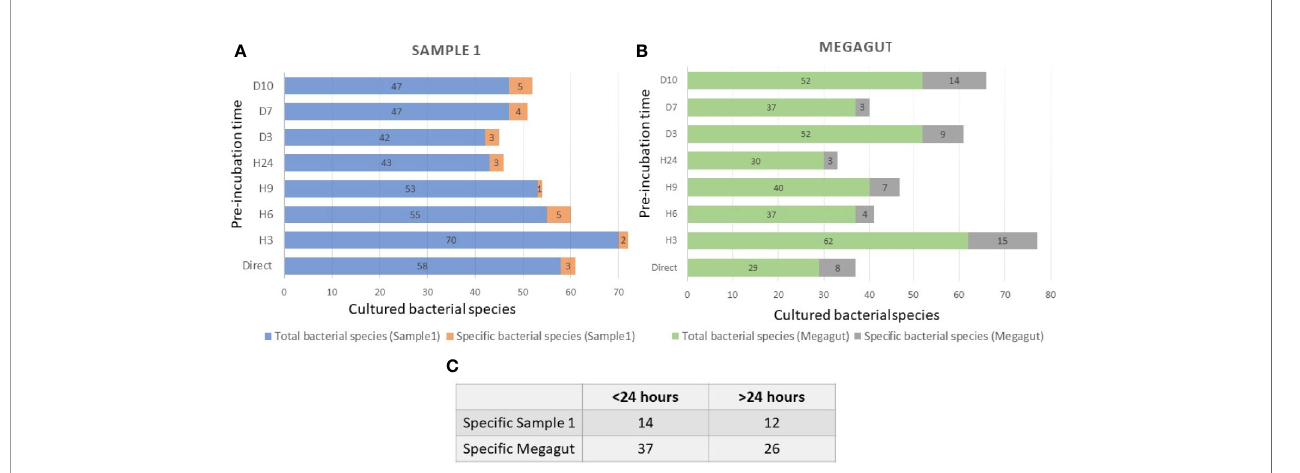
FIGURE 2 | Total and speci fi c number of bacterial species isolated in stool samples as a function of the incubation times. (A) Blue histograms represent the total number of species identi fi ed in the fi rst stool sample (Sample 1) at different incubation times. The orange histograms show the number of bacterial species only found at different incubation times in the fi rst stool sample (Sample1). (B) Green histograms represent the total number of species identi fi ed in the second stool sample (Megagut) at different incubation times. The gray histograms show the number of bacterial species only found at different incubation times in the second stool sample (Megagut). (C) Table 2C represents the number of bacteria cultured only before or after 24 h of pre-incubation in liquid